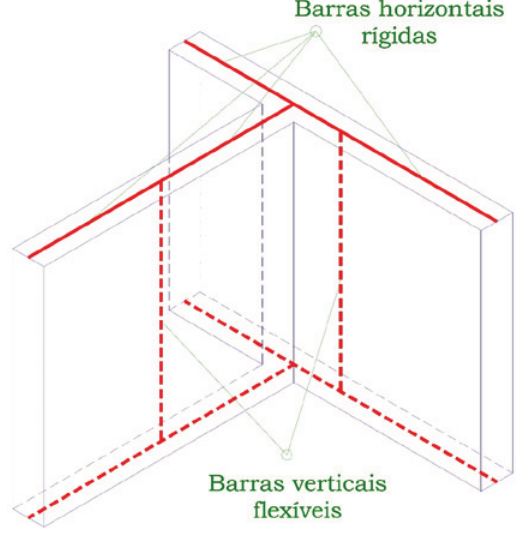
Discretização da parede em elementos de barra (Fonte: Nascimento Neto,